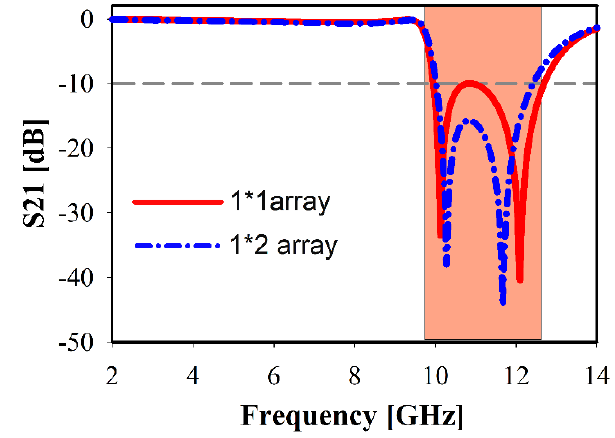
6 of 16 Figure 4. Simulated metamaterial reflection and transmission coefficients.